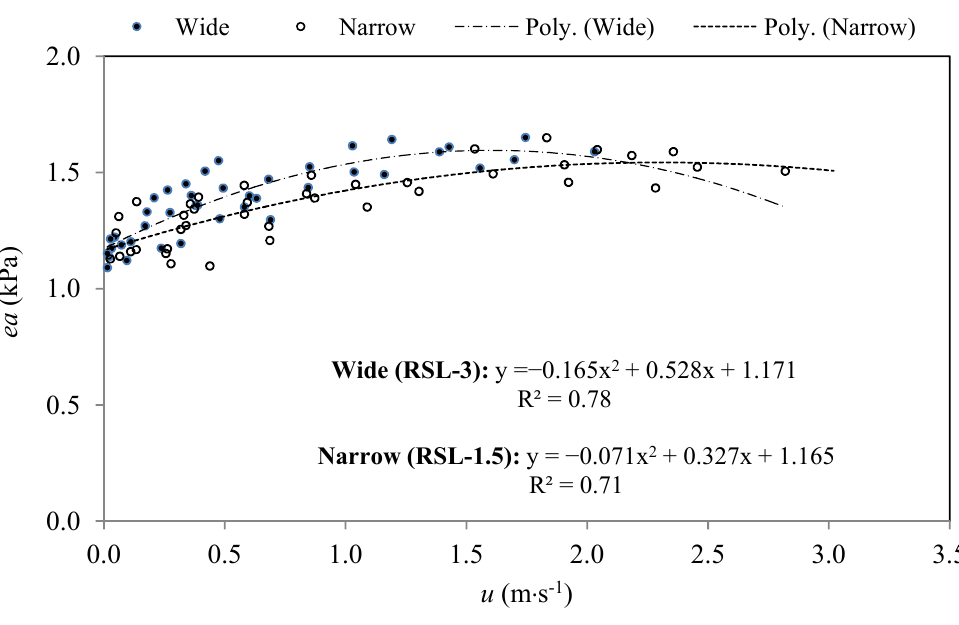
Figure 7. Daytime relationship between wind speed ( u ) and water vapor ( ea ) of all profile measurements ( n = 40) on 6 February 2009 (47 DAP), on wide and narrow runoff